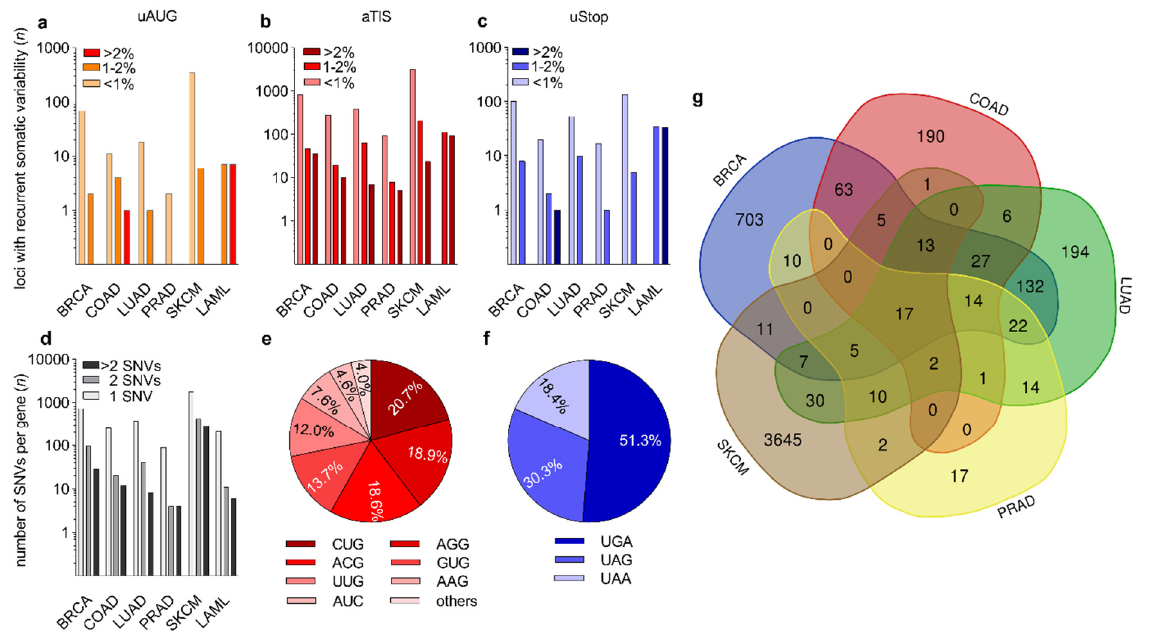
Figure 2. Recurrent somatic uORF-associated SNVs in six types of human cancer. ( a – c ) Bar graphs showing the number ( n ) of ( a ) uAUG-, ( b ) aTIS-, and ( c ) uStop-associated recurrent SNVs observed in breast invasive carcinoma (BRCA), colon adenocarcinoma (COAD), lung adenocarcinoma (LUAD), prostate adenocarcinoma (PRAD), skin cutaneous melanoma (SKCM), and acute myeloid leukemia (LAML). Coloring of bars indicates whether SNVs affected <1%, 1–2%, or >2% of patients for each type of cancer. ( d ) Bar graph showing the number of genes ( n ) affected by 1, 2, or >2 SNVs in indicated types of cancer. ( e , f ) Pie charts displaying the relative distribution of recurrent somatic SNVs affecting the indicated types of ( e ) aTIS and ( f ) uStop codons. (others = AUU (2.4%) and AUA (1.5%)). ( g ) Venn diagram showing the number of shared recurrent somatic SNVs among indicated types of cancer.